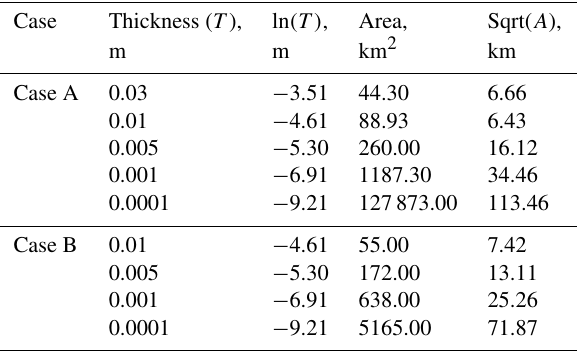
Table A3. Areas ( A ) enclosed by each isopach of certain thickness ( T ) and their respective natural logarithm (ln (T ) ) and square roots (Sqrt( A )), as used for the volume estimates in both A and B scenar- ios of tephra distribution.